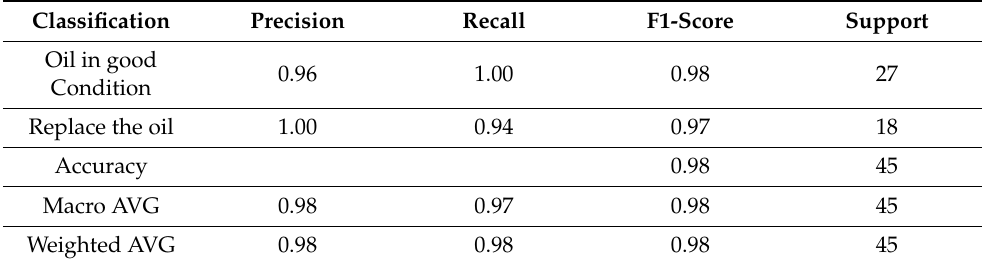
Table 3. Classification of the lubricating oil results.